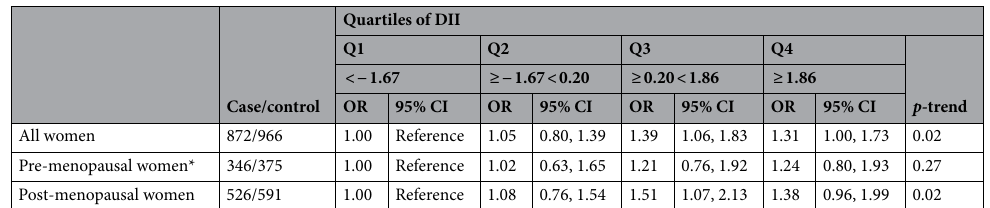
Table 3. Odds ratios (ORs) and 95% confidence intervals (CIs) for breast cancer associated with Dietary Inflammatory Index (DII). All women and stratification by menopausal status. The CECILE study, France, 2005–2007. P trend determined from the model using the median value in each quartile as a continuous variable. Odds ratios adjusted for study area, age as continuous variable, history of benign breast, family history of breast cancer in first-degree relatives, age at menarche, parity, age at first full-term pregnancy, breast feeding, menopausal status, current use of hormone therapy, oral contraceptive use and body mass index. *Not adjusted for current use of hormone therapy. P -value for interaction (DII x menopausal status):